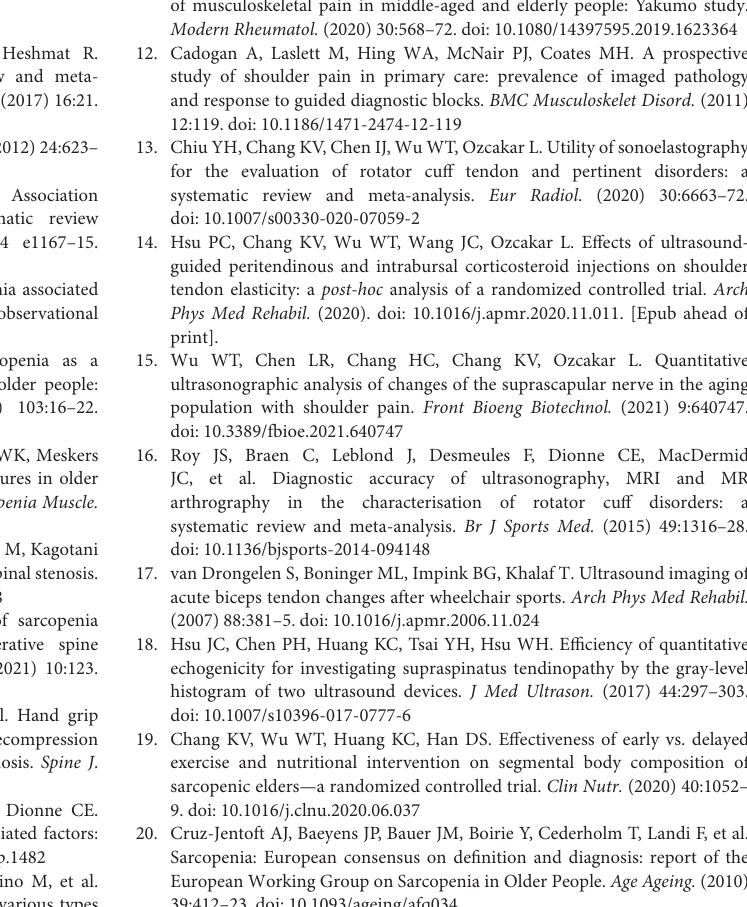
Supplementary Figure 1 | The line tool (A) and histogram (B) for measuring thickness and echogenicity.